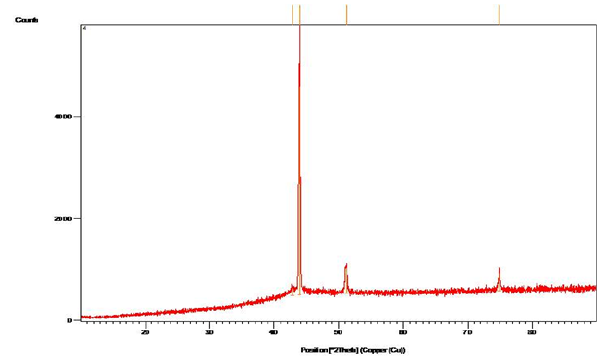
Figure 13: XRD analysis of work